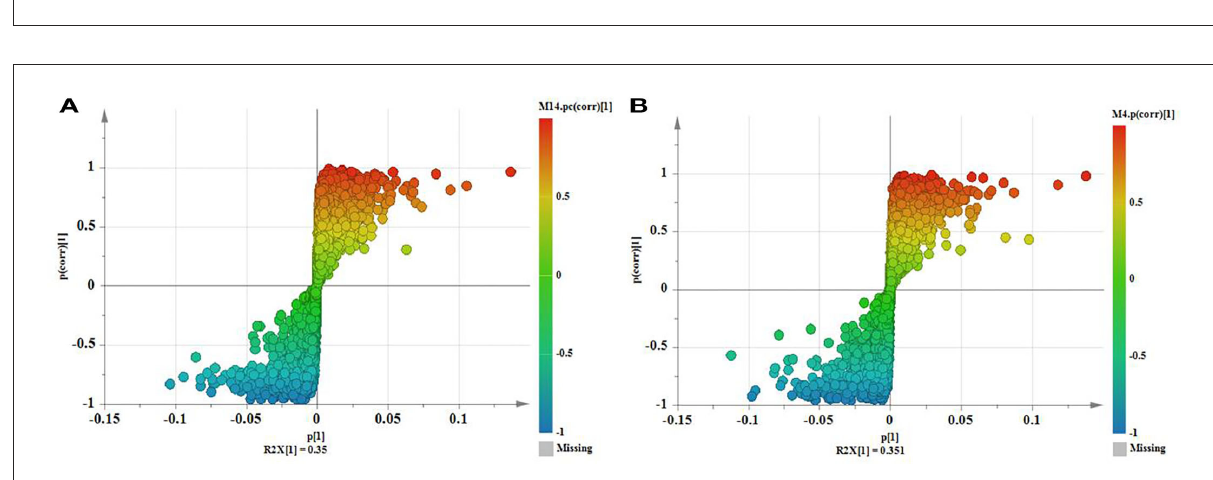
FIGURE6 S-Plot of DY and DYWC [ (A) positive mode; (B) negative